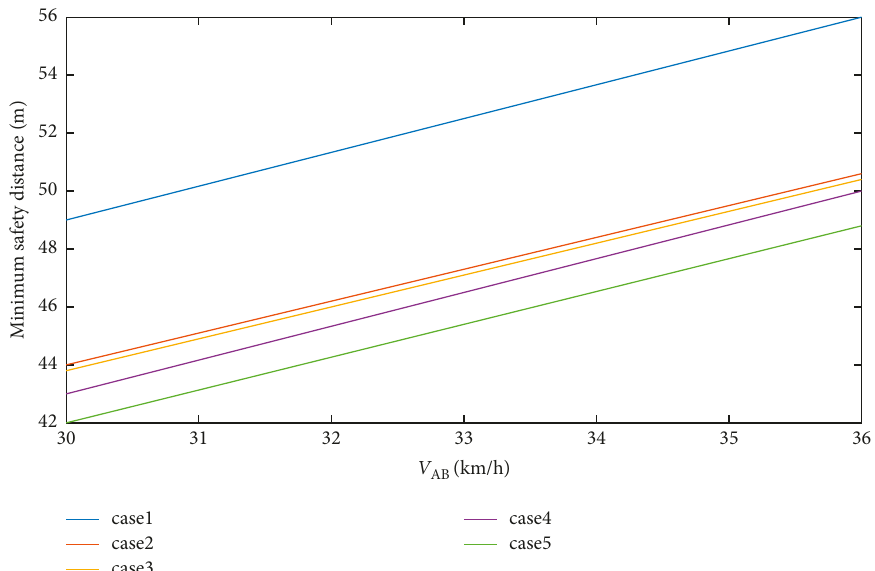
Figure 4: Minimum safety distances under constant speed state of the front vehicle ( v ′ is large).